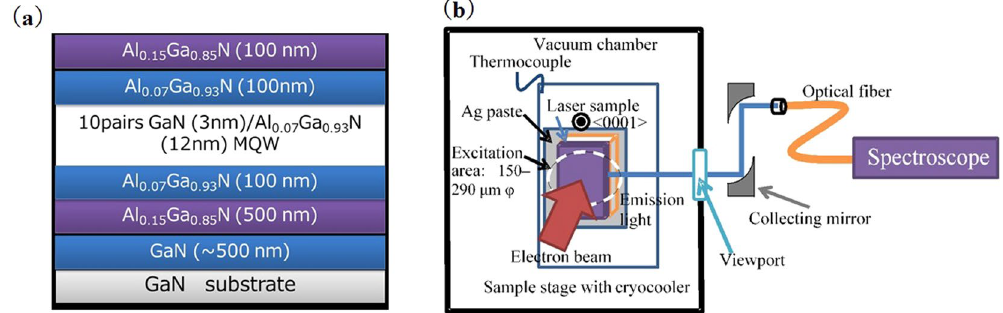
Figure 1. ( a ) Schematic view of the sample structure. ( b ) Exterior photograph of the electron beam excitation and measurement systems.